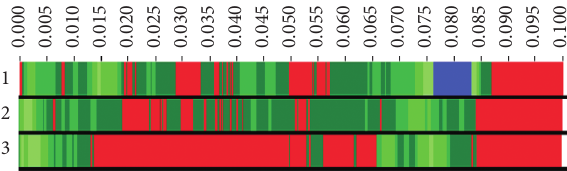
Figure 3: Compaction process of an unbound bearing layer can be visualized by CCC measurements. The evaluation process is described in detail in